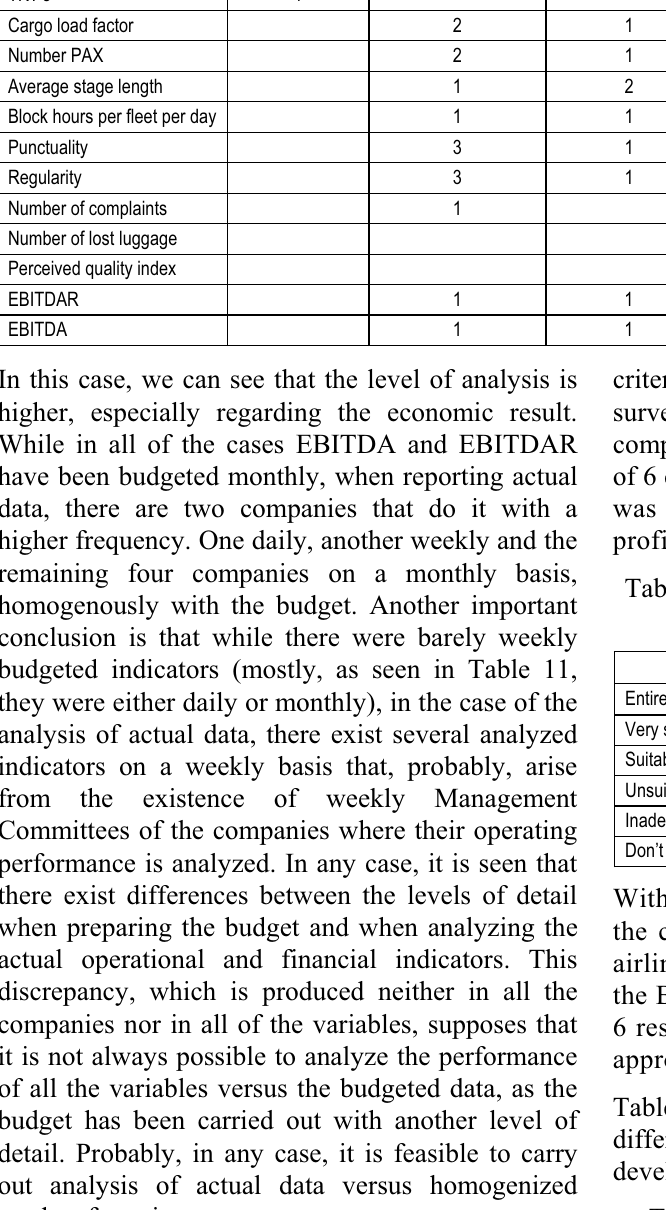
Table 14. Answer to the question: